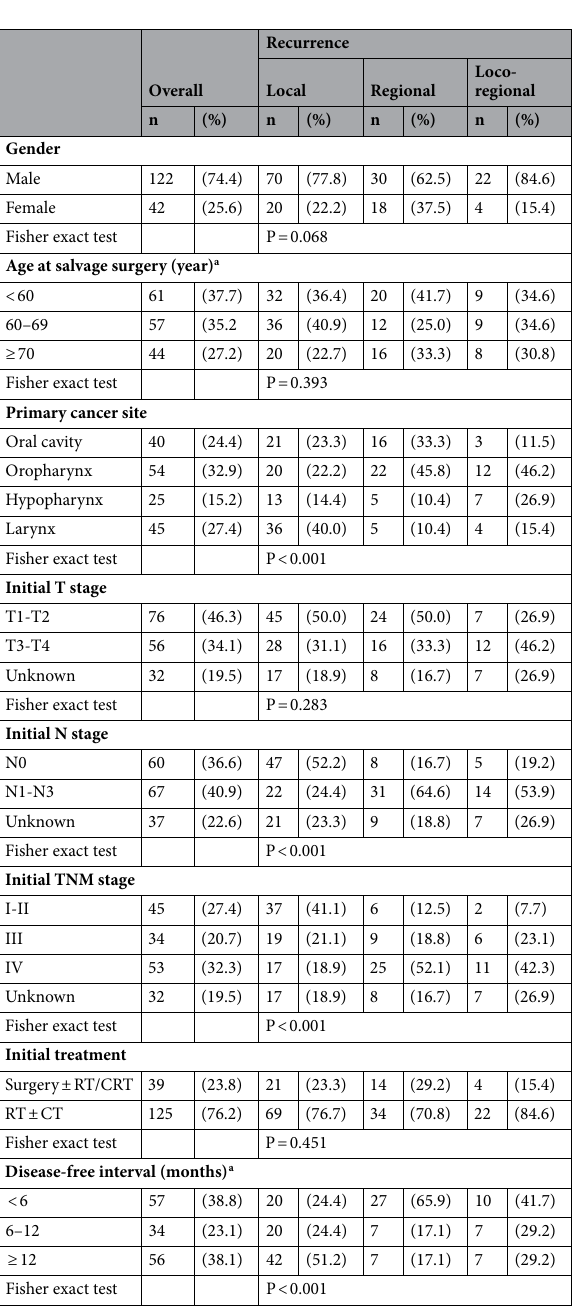
Table 1. Distribution of 164 patients undergoing salvage surgery after recurrent head and neck cancer, according to sociodemographic and pre-operative clinical characteristics. RT radiotherapy, CT chemotherapy, CRT chemo-radiotherapy. a The sum does not add up to total because of missing